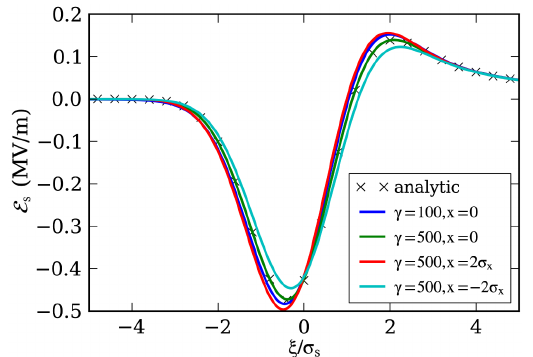
FIG. 10. The on-axis longitudinal CSR field E parameters in Fig. 9 and with (cid:2) ¼ 100 ; 500 , which corresponds to scaled longitudinal beam spot size of 200, 25 000, respec- tively. For (cid:2) ¼ 500 , the fields at x ¼ (cid:14) 2 (cid:16) also shown. The analytic result from 1D models [5,6] is plotted for comparison.